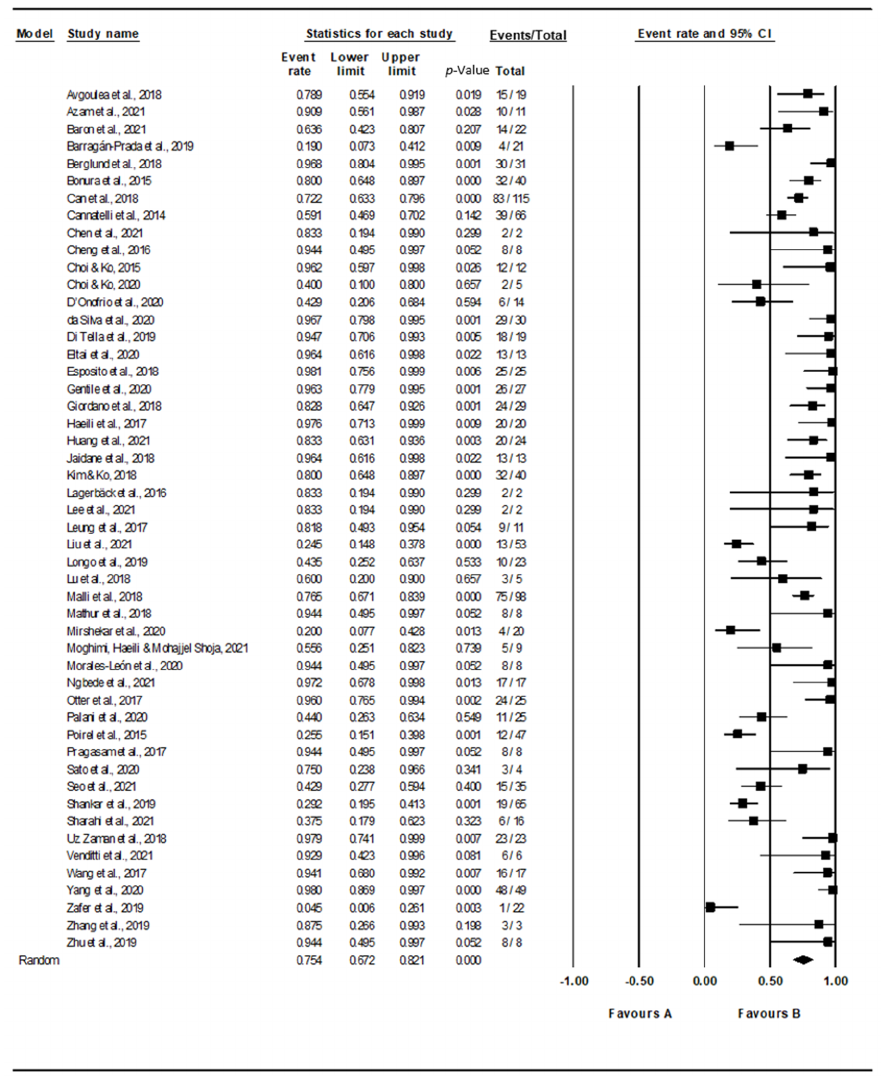
Figure 3. Forest plot showing the pooled prevalence of mutated colistin-resistant K. pneumoniae (ColRkp) estimated by a random effect model of meta-analysis (75.4%, I 2 = 81.742, 95% CI = 67.2–82.1, p -value < 0.001). The event rate was calculated to report the summary effect size. Studies are displayed as squares, and size of the square indicates the weight given to the study in meta-analysis using CMA software [12–61].